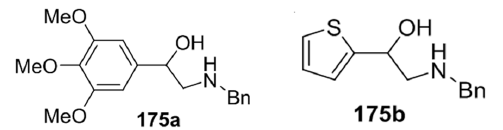
Figure 3. Products from hydrazinolysis of oxazolidines 173j and 173r .